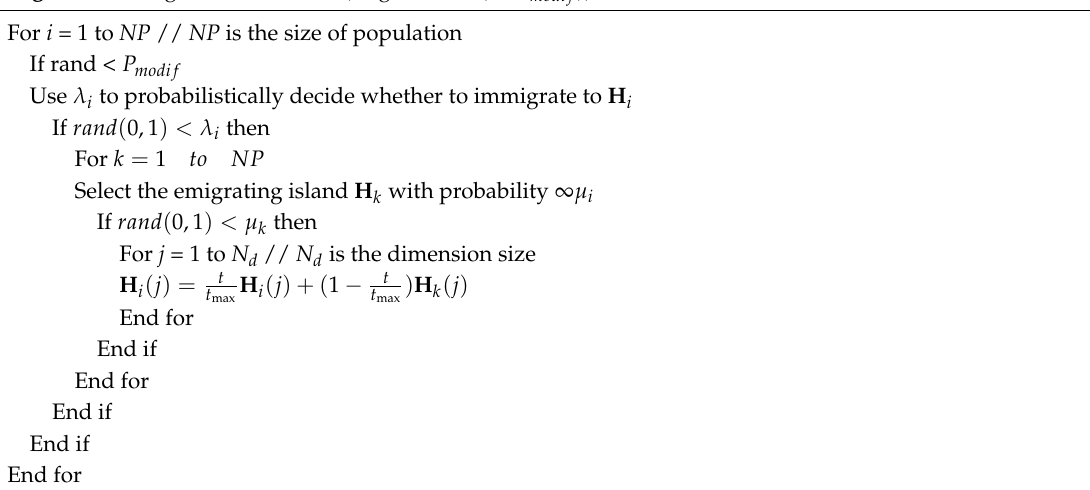
Algorithm 1 Migration for MOPs (MigrationDo(H, P modif )) For i = 1 to NP // NP is the size of